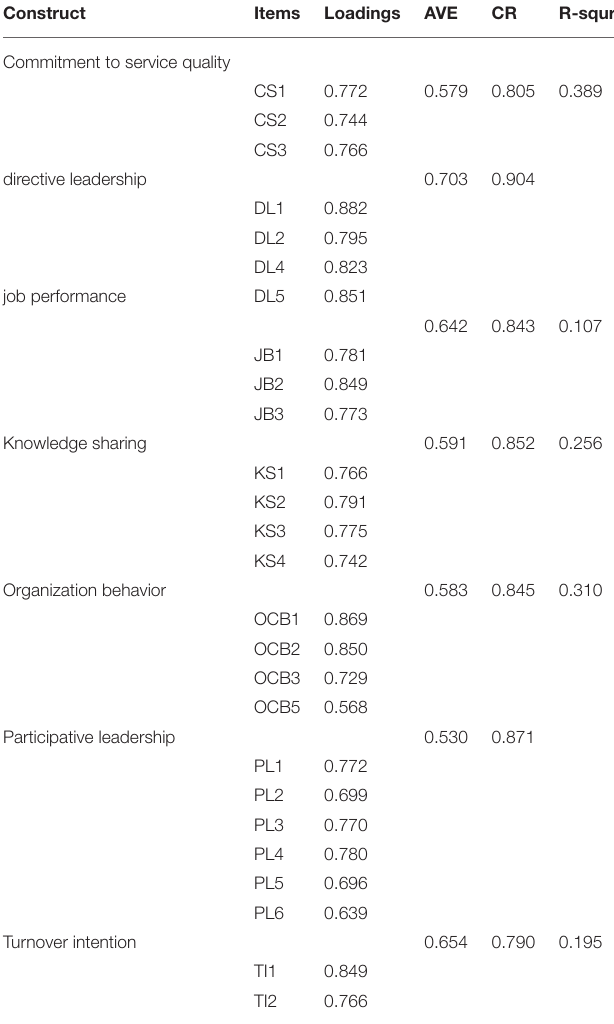
TABLE 1 | Measurement